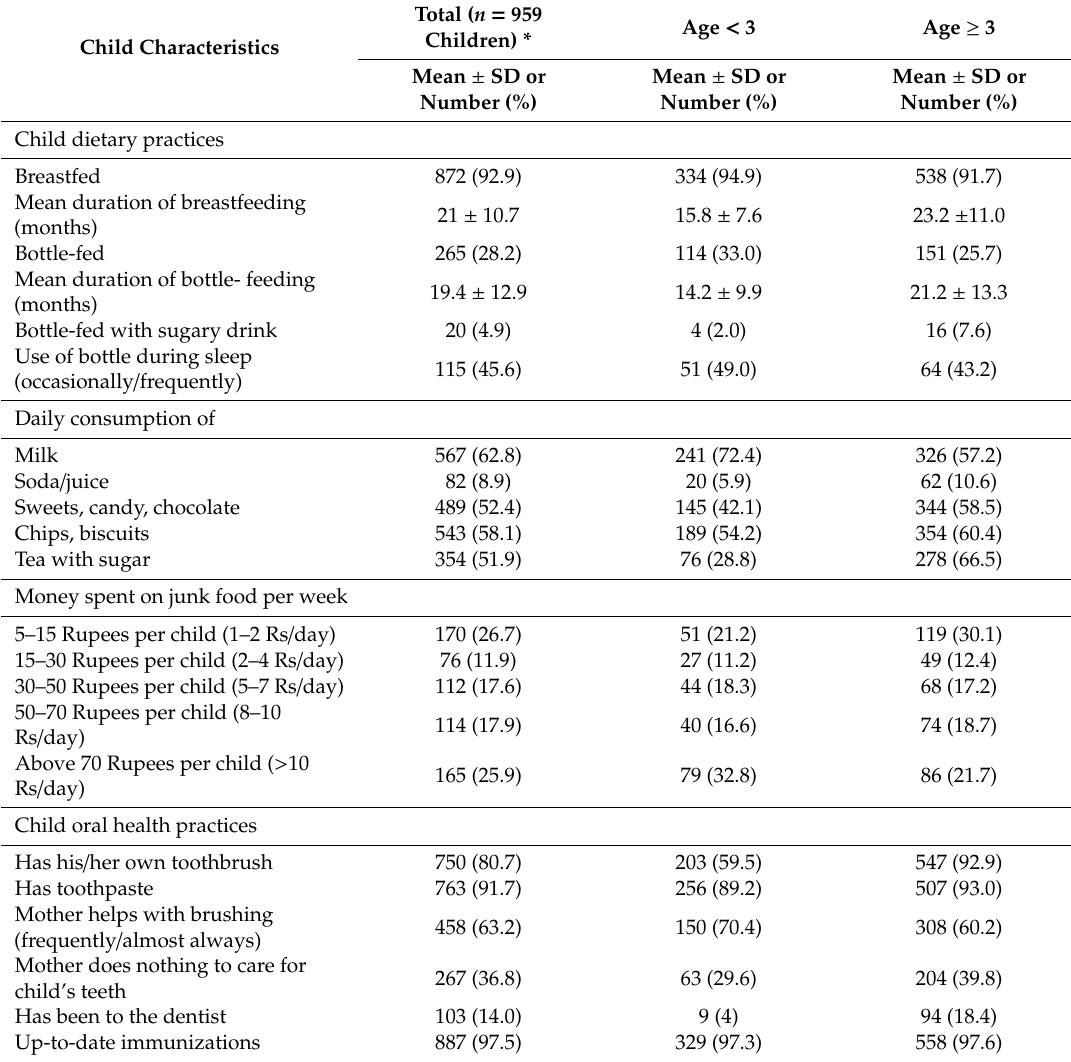
Table 3. Child Dietary and Oral Health